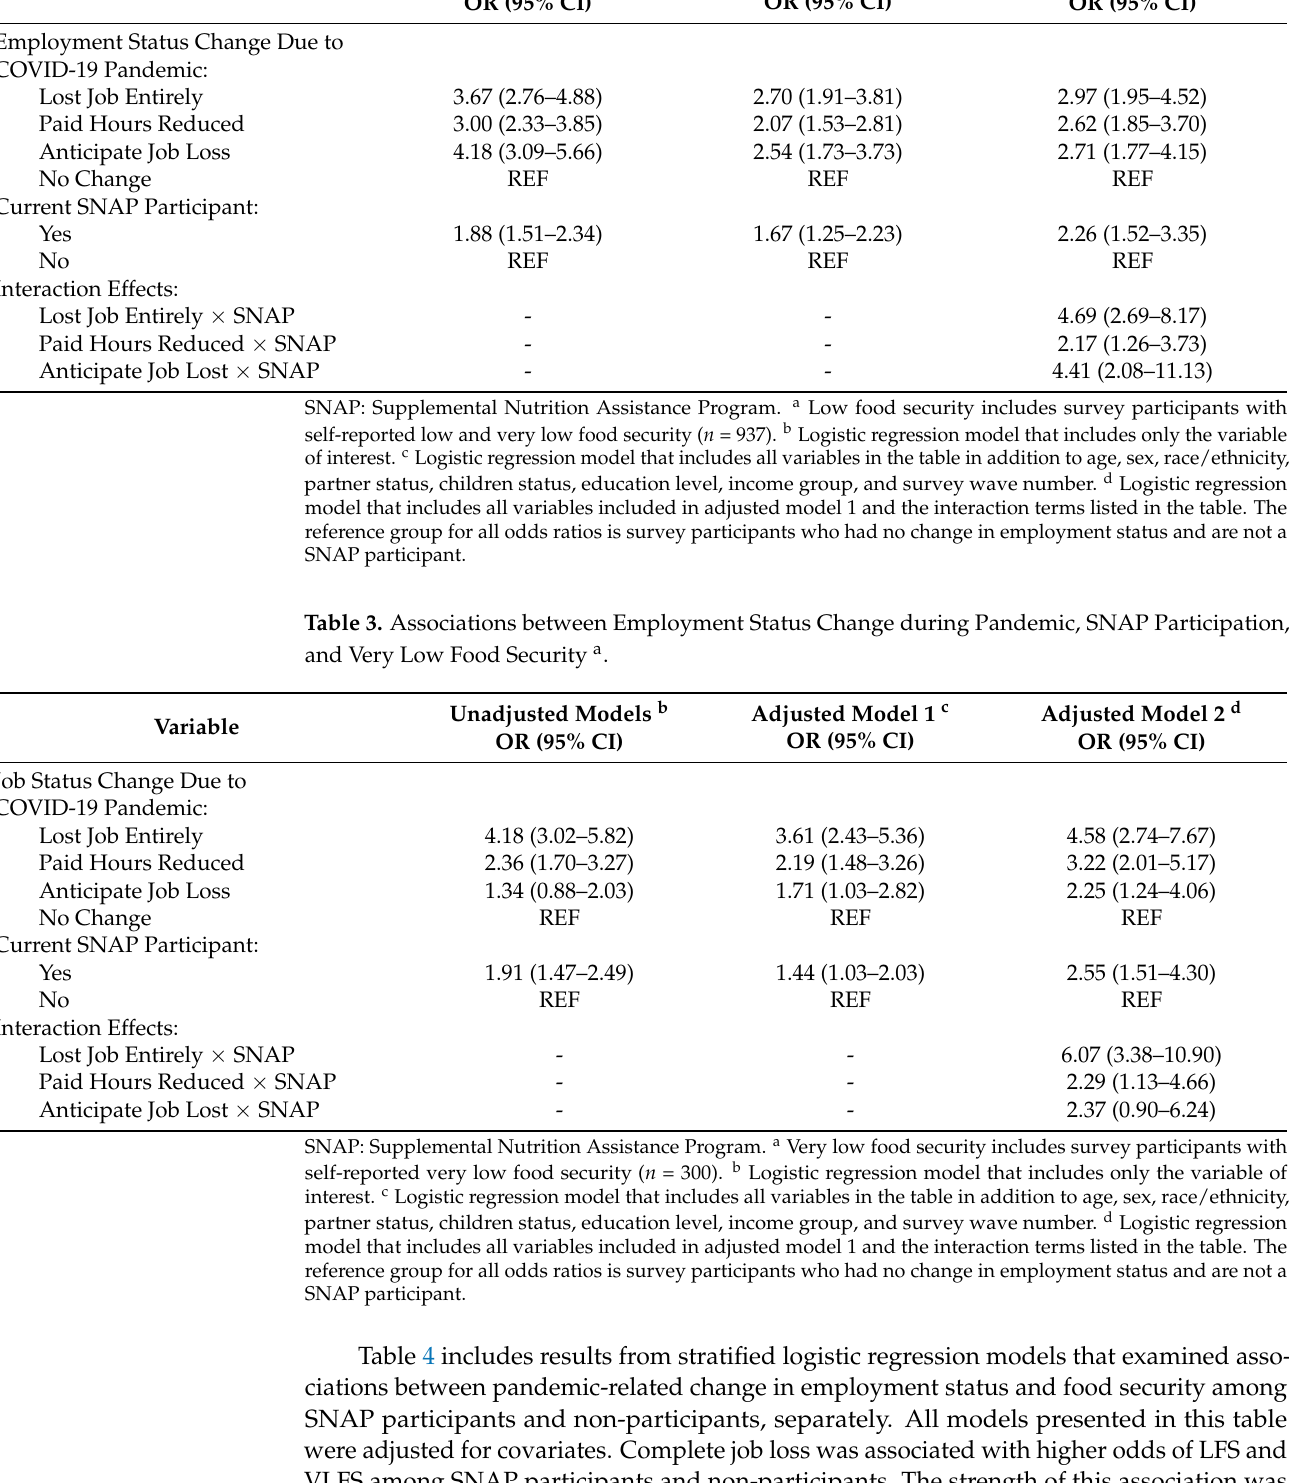
Table 4 includes results from stratified logistic regression models that examined asso- ciations between pandemic-related change in employment status and food security among SNAP participants and non-participants, separately. All models presented in this table were adjusted for covariates. Complete job loss was associated with higher odds of LFS and VLFS among SNAP participants and non-participants. The strength of this association was higher among non-participants compared to SNAP participants. For example,